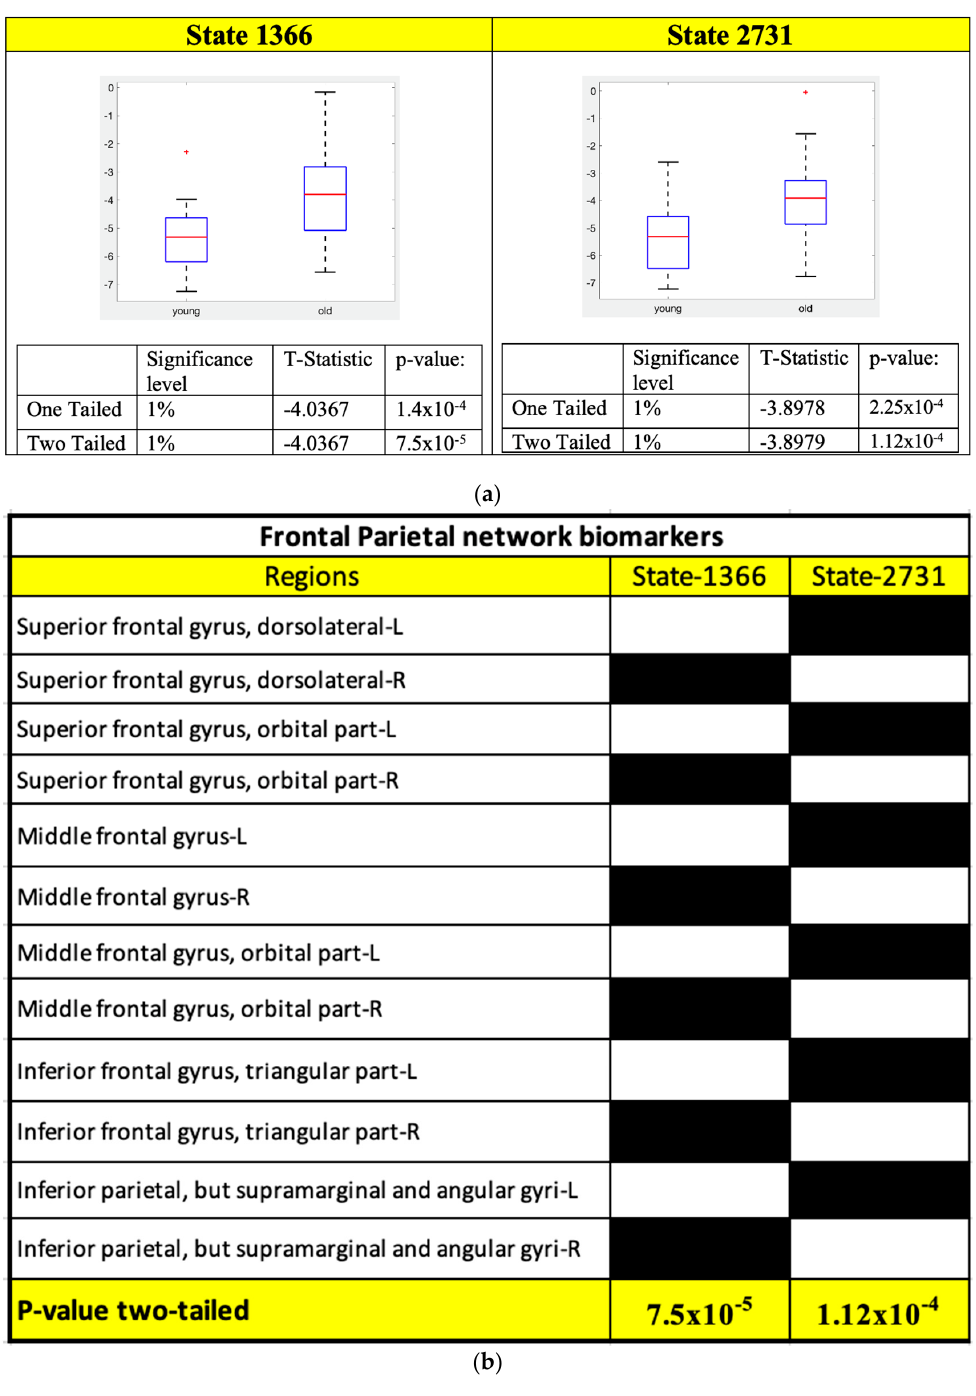
Figure 4. Two–sample t -test was performed on the local minimum states of the FPN whose energy difference was maximum and the states whose p –values satisfy the Bonferroni correction are considered potential connectivity signatures. ( a ) Two–sample t -test results of the connectivity signature state which satisfy the Bonferroni correction for FPN. ( b ) Connectivity signature states definitions for FPN.